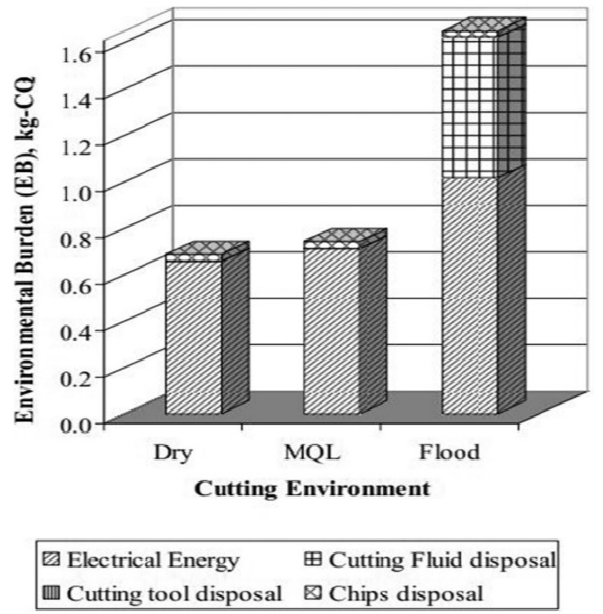
Figure 1. Comparison of the environmental burden of dry, flooded, and minimum quantity lubrica- tion (MQL) [23].